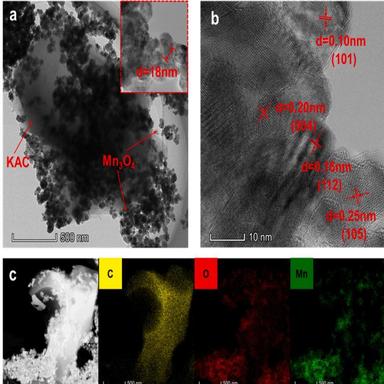
(a) TEM image of MKAC-180, (b) High-resolution TEM image of MKAC-180, (c) TEM images MKAC-180 and the corresponding element mapping: C, O and Mn.